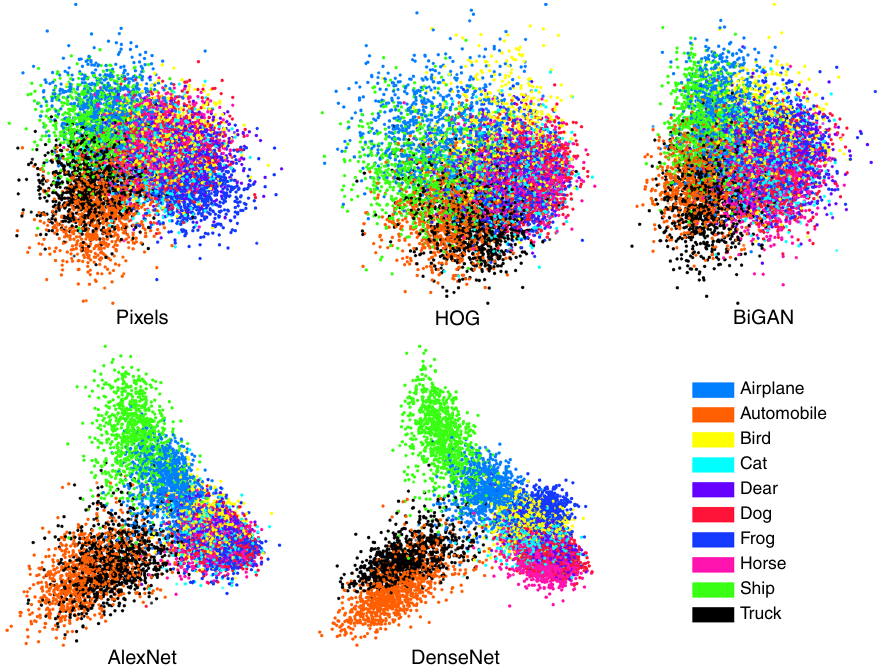
Fig. 4 Stimulus representations. Two-dimensional linear-discriminant-analysis projections of the fi ve stimulus representations used in our analyses, for all stimuli (colored by category). As the representation quality increases from left to right, the apparent class separability increases while within-class variability decreases.